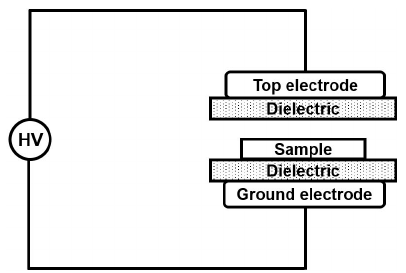
Figure 1. A schematic of dielectric barrier discharge (DBD). The left part of HV (High voltage source) represents a compact microsecond ‐ pulse generator.